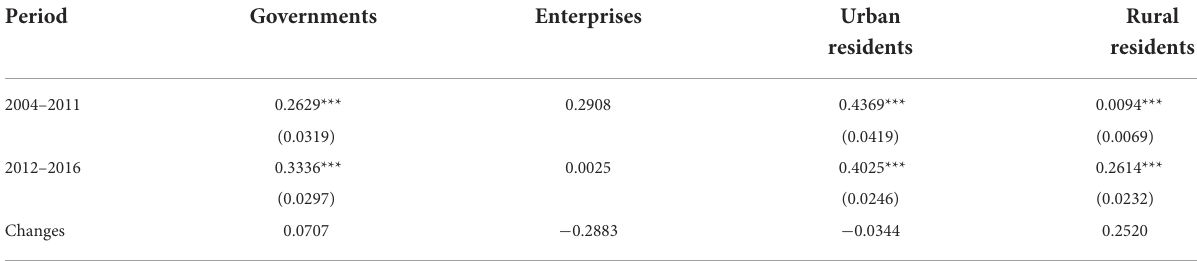
TABLE 1 Environmental regulation dividends